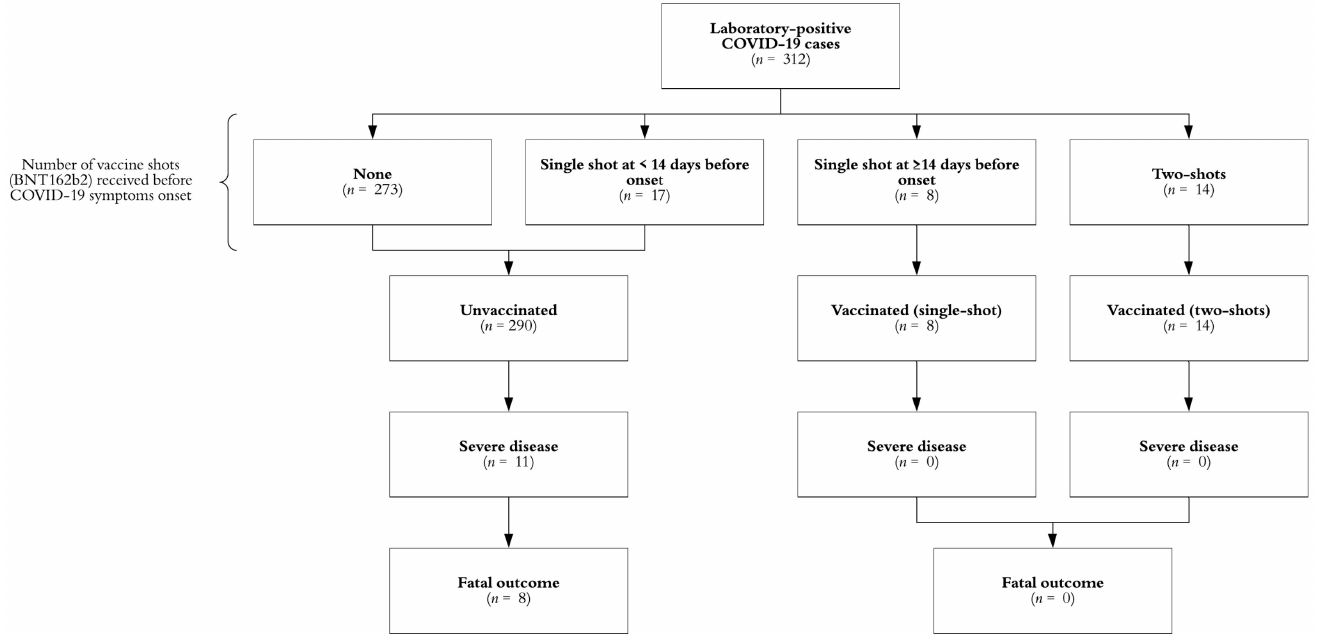
Figure 1. Study profile, Mexico 2021. Abbreviations: COVID-19, coronavirus disease